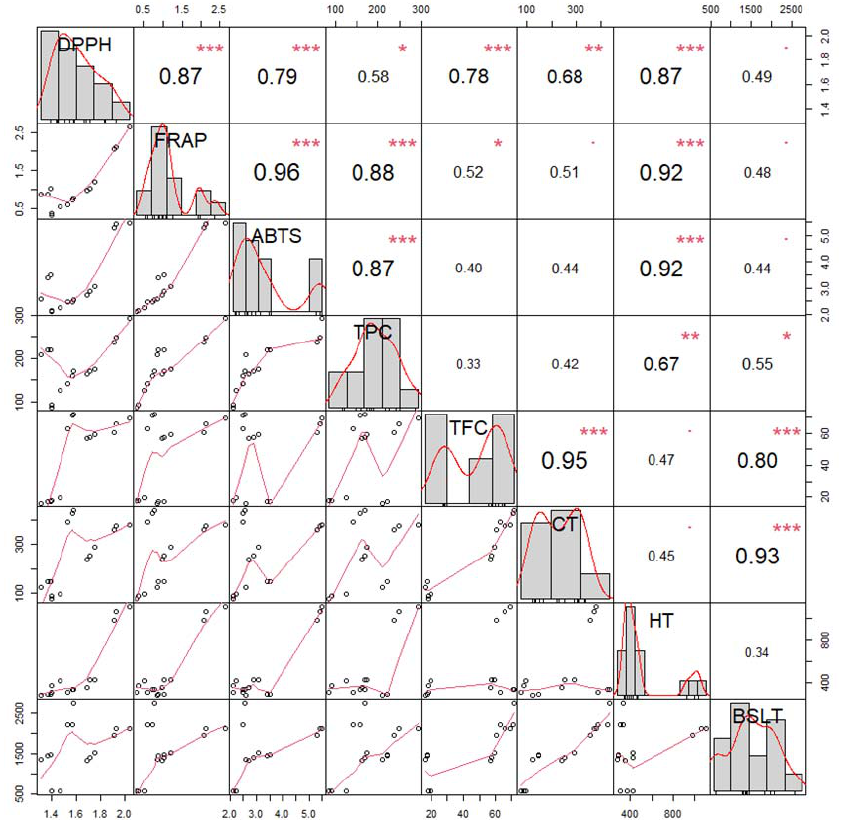
Figure 1. Pearson’s correlation matrix of pharmacological and phytochemical variables describing Acacia heartwood extracts. The diagonal, top right, and bottom left boxes represent the data distribution of each variable, the correlation coefficient, and the bivariate scatter plot, respectively.